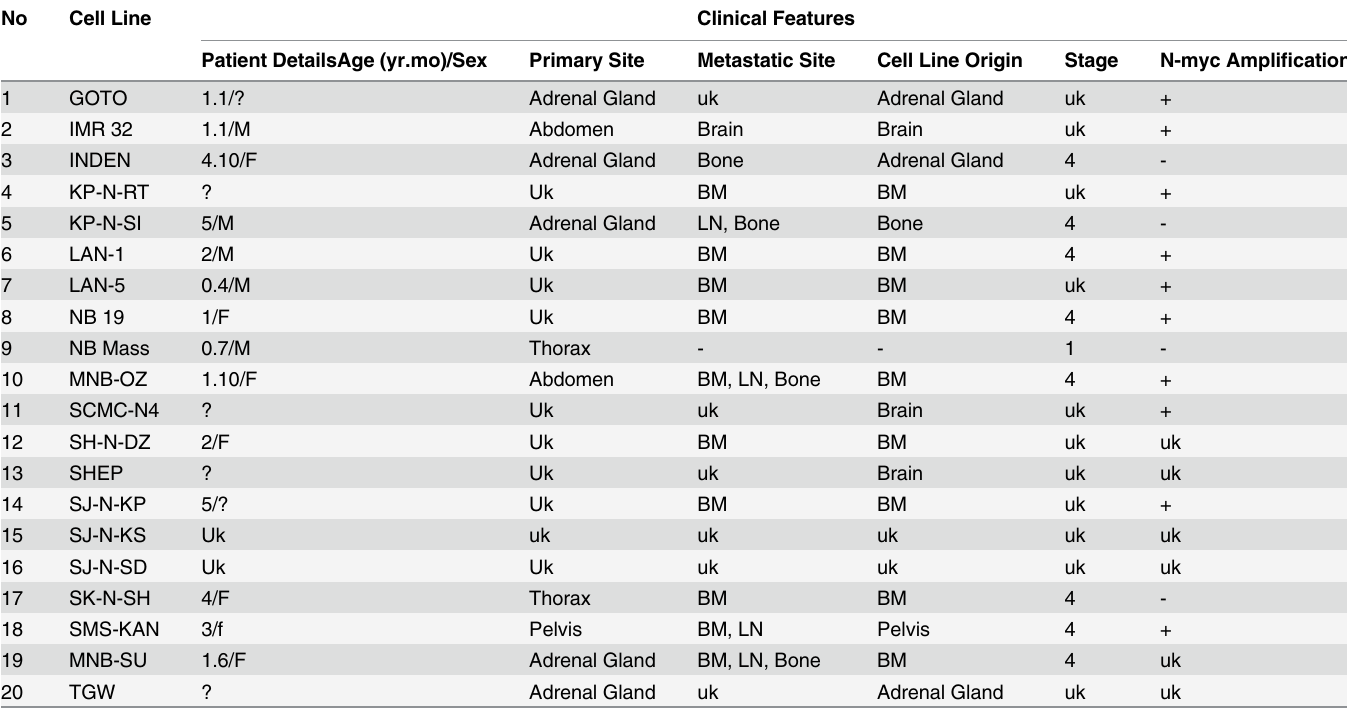
Table 1. Neuroblastoma cell lines and their clinical